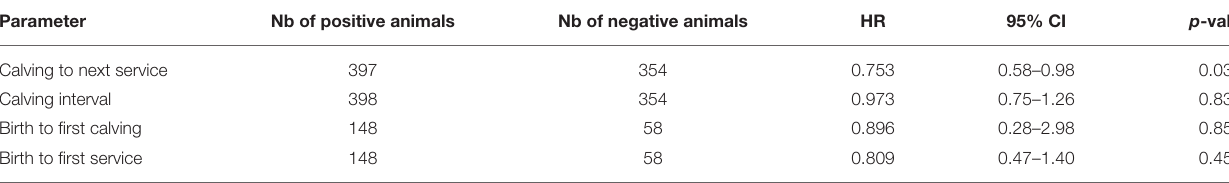
TABLE 1 | Hazard ratios for fertility parameters among BTB-positive cows.